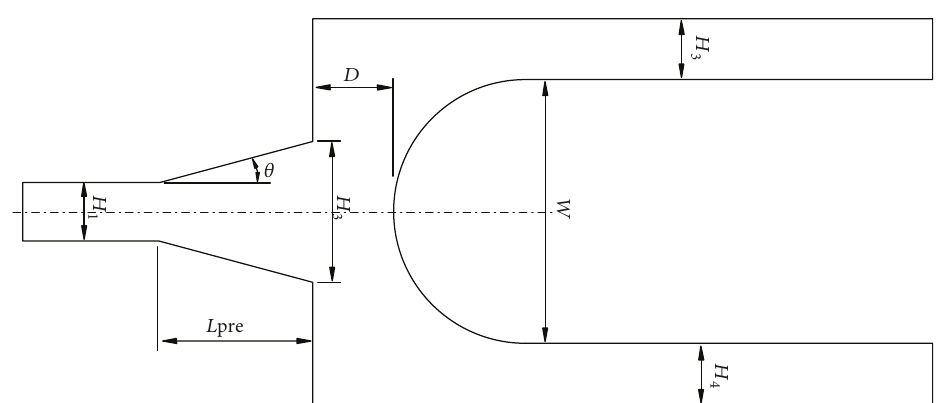
Figure 11: Idealized physical model of dump di ff user with straight-walled predi ff